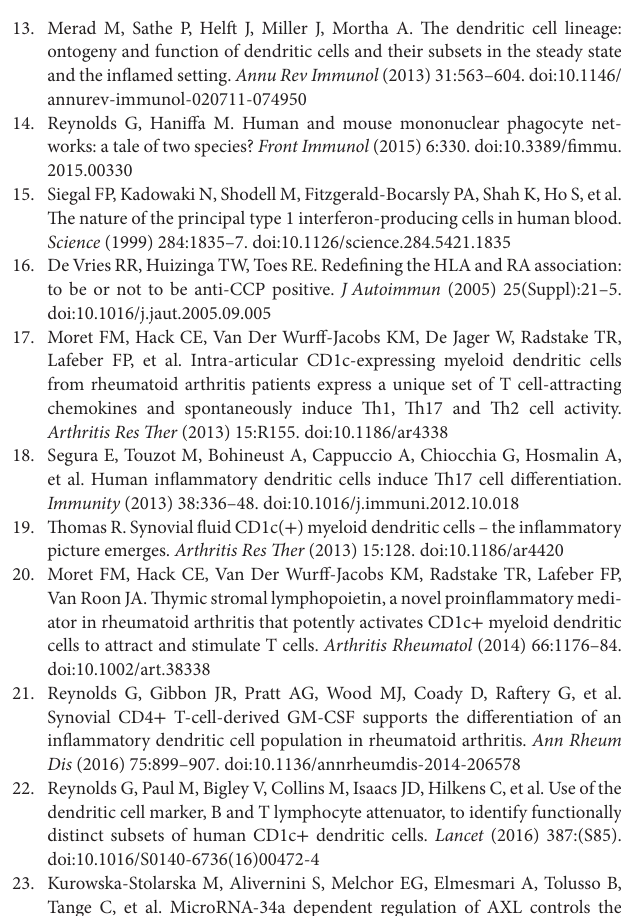
FigUre s2 | Plasmacytoid DC (pDC), CD1c + DC, and CD141 + DC number and frequency in early RA whole blood. Plots depict early RA DC number ( × 10 6 /L) and frequency (%) in the whole blood for (a) pDCs, (B) CD1c + DCs, and (c) CD141 + DCs. Linear